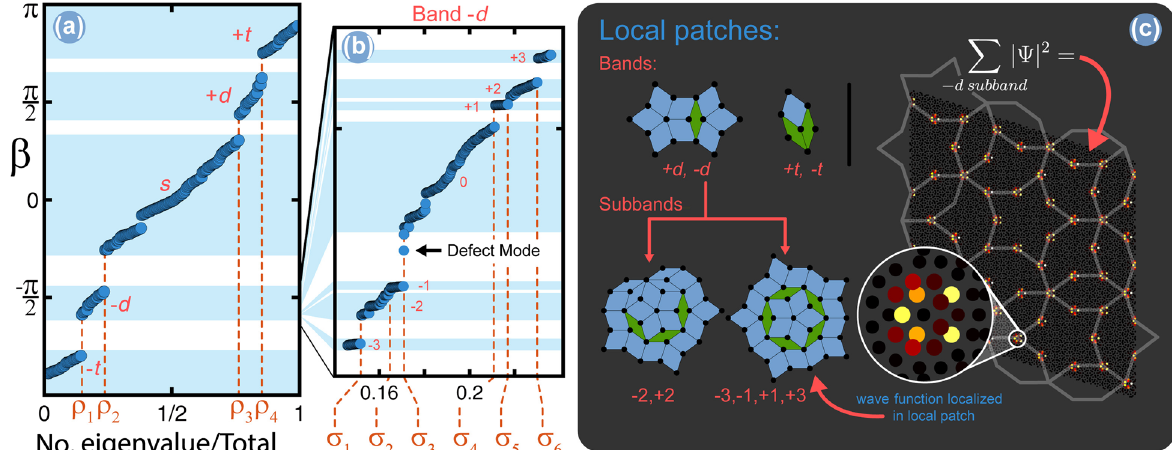
FIG. 2 (a) Quasienergy spectrum of a periodic Penrose tiling approximant containing 9349 vertices. ρ gaps labeled (from the highest downwards) as þ t , þ d , s , − d , and − t . (b) Zoomed-in section of the quasienergy spectrum of quasiband − d . σ mark the positions of the “ subgaps ” of the − d band. (c) Left: Local patches associated with the ( þ d; − d ) bands and the ( þ t; − t ) i bands, and local patches associated with the − d band, giving rise to several subbands. Right: Sum of the modal intensities of the modes associated with the − 3 subband.